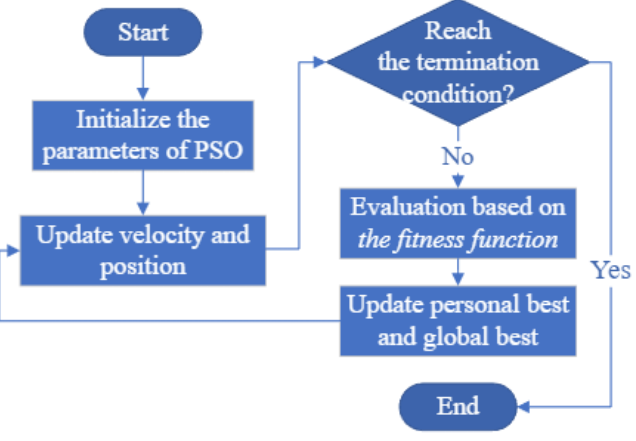
Figure 6. Flowchart of the PSO